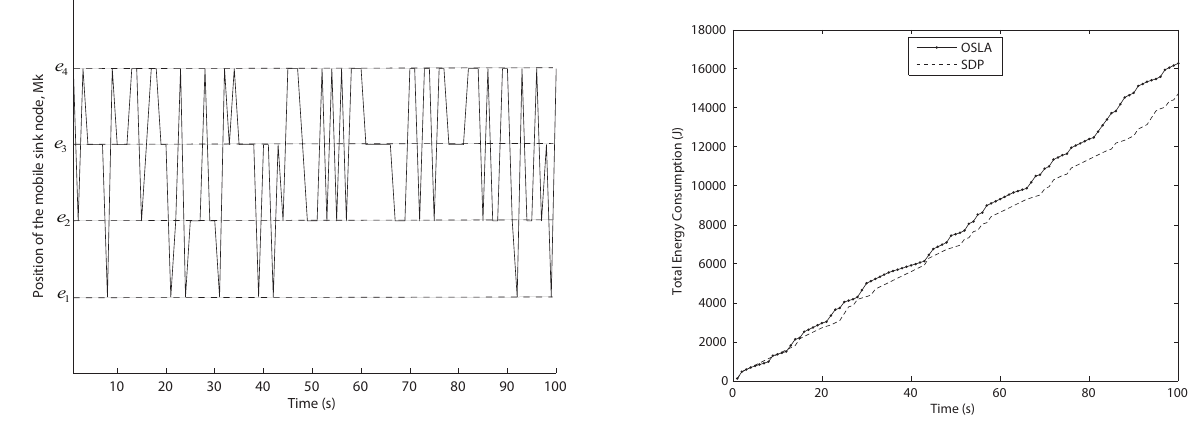
Figure 8. (a) Simulated position of the mobile sink node with time. (b) Total energy con- sumption obtained by OSLA and SDP for T = 100